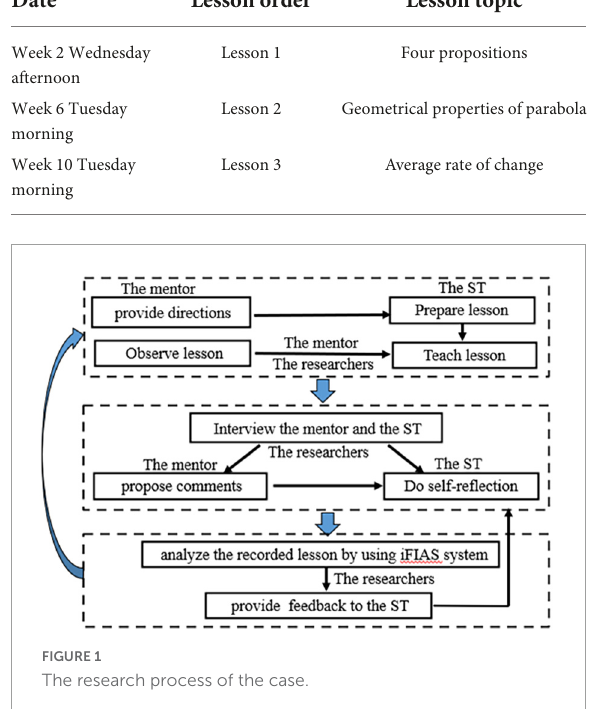
FIGURE1 The research process of the